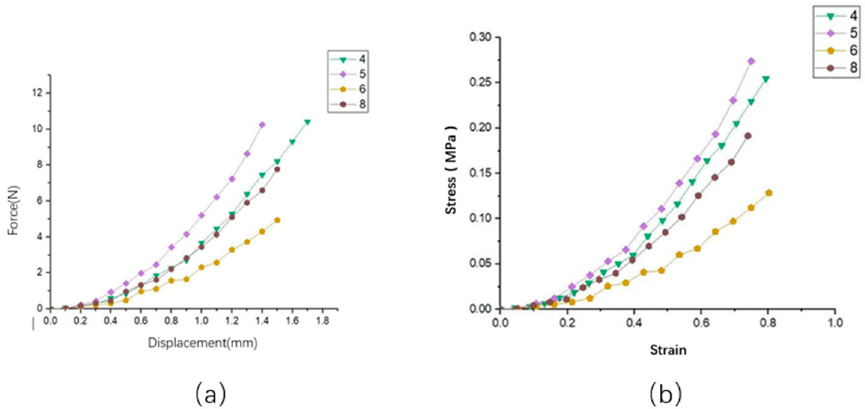
Figure 3. Test hairy vetch steam. ( a ) Radial compression test; ( b ) Axial tensile test; ( c ) Radial bending test.